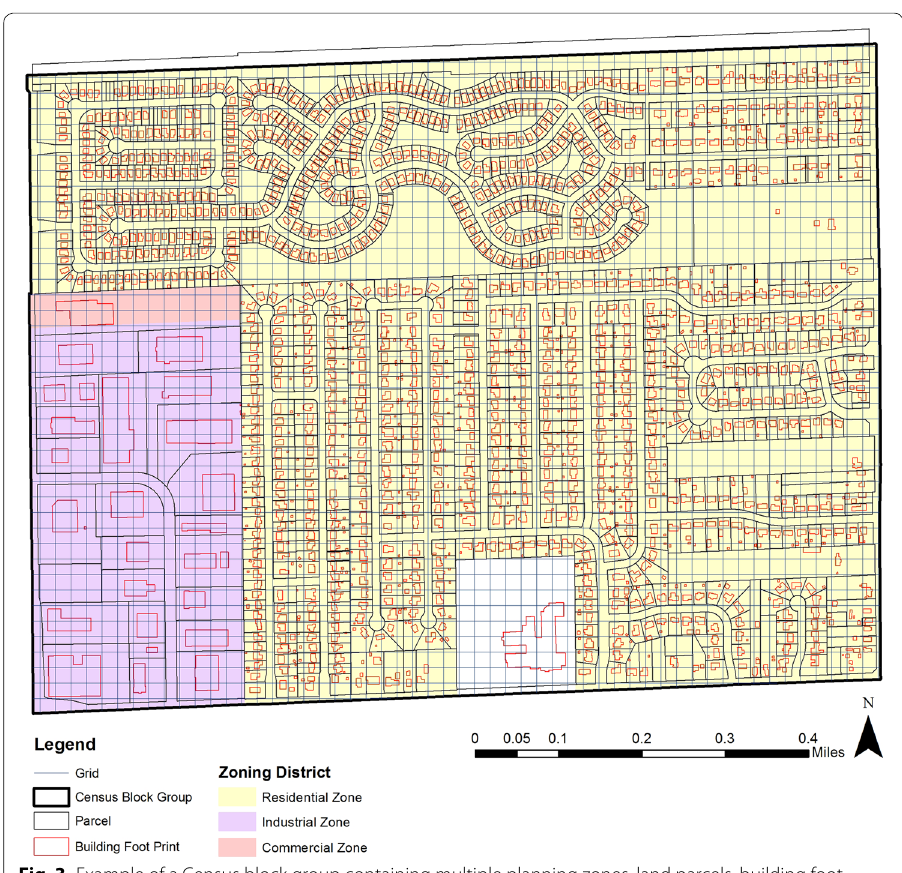
Fig. 3 Example of a Census block group containing multiple planning zones, land parcels, building foot- prints, and raster